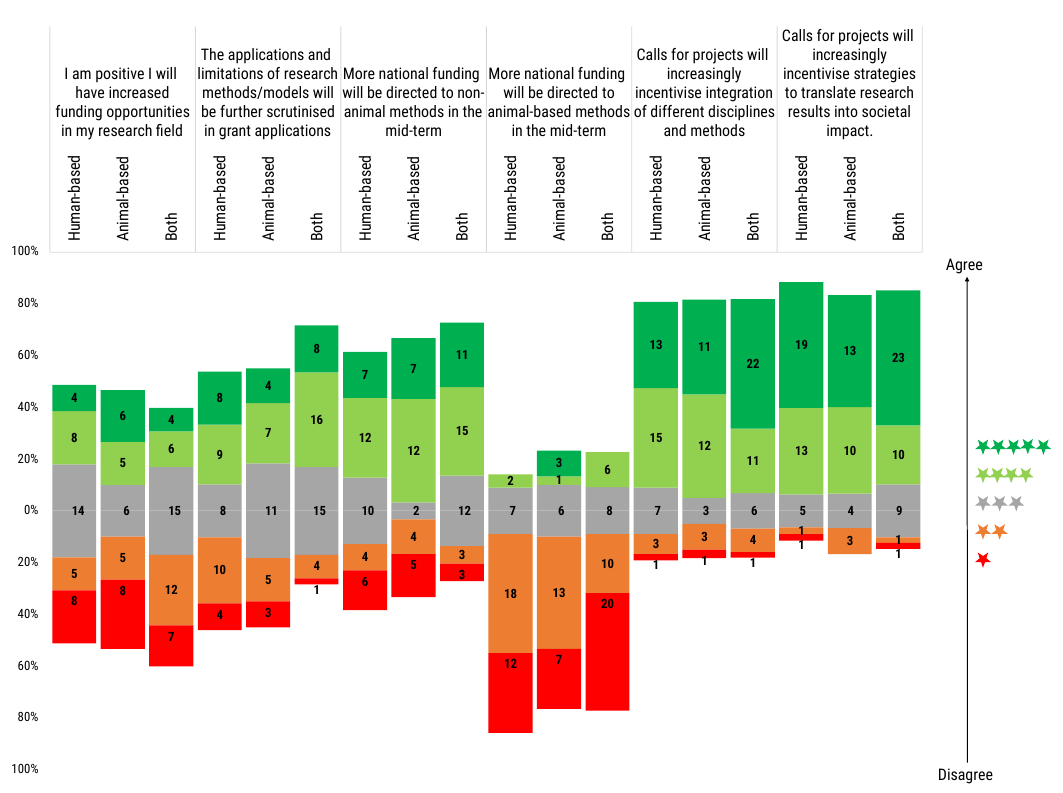
Figure 7. Participants were asked to rate a series of statements regarding funding opportunities. Rating scale was from 1 (red) to 5 (green) stars. Histogram dimensions are represented as 100%, where 100% is the total number of participants of each subgroup: human-based (39), animal-based (30) and both (44) model users. The stacked chart, calibrated around the neutral score (3 stars), shows the number of respondents based on their degree of agreement and segmented by researchers’ use of animal - or human-based or both models. I am positive I will have increased funding opportunities in my research field: The total dis- tribution of researchers response was almost equally divided on this question, only scep- tics were slightly more represented (29.2% optimistic vs. 31.0% neutral vs. 39.8% sceptic). Disaggregating the results, human-based model users were equally distributed on this topic (30.8% optimistic vs. 35.9% neutral vs. 33.3% sceptic) in comparison with the other two groups. In fact, animal-based model users answers were more polarized (36.7% opti- mistic vs. 20.0% neutral vs. 43.3% sceptic). In contrast with the other two groups, the an- swers by the users of both types of model showed less optimism in an increase in funding in their research field (22.7% optimistic vs. 34.1% neutral vs. 43.2% sceptic). The applications and limitations of research methods/models will be further scrutinised in grant applications: Users of both human- and animal-based models were convinced that applications and limitations of research models will be further scrutinised (54.5% vs. 11.4%). The situation was relatively more balanced for human-based (43.6% vs. 35.9%) and animal-based models users (36.7% vs. 26.7%), where both opposite perceptions are almost equally represented, with a small advantage for those believing in further scrutiny. More national funding will be directed to non-animal methods in the mid-term : The majority of respondents (56.6%) expressed conviction that more funding for non-animal methods at national level will increase in the mid-term. Proportionally, more convinced in such